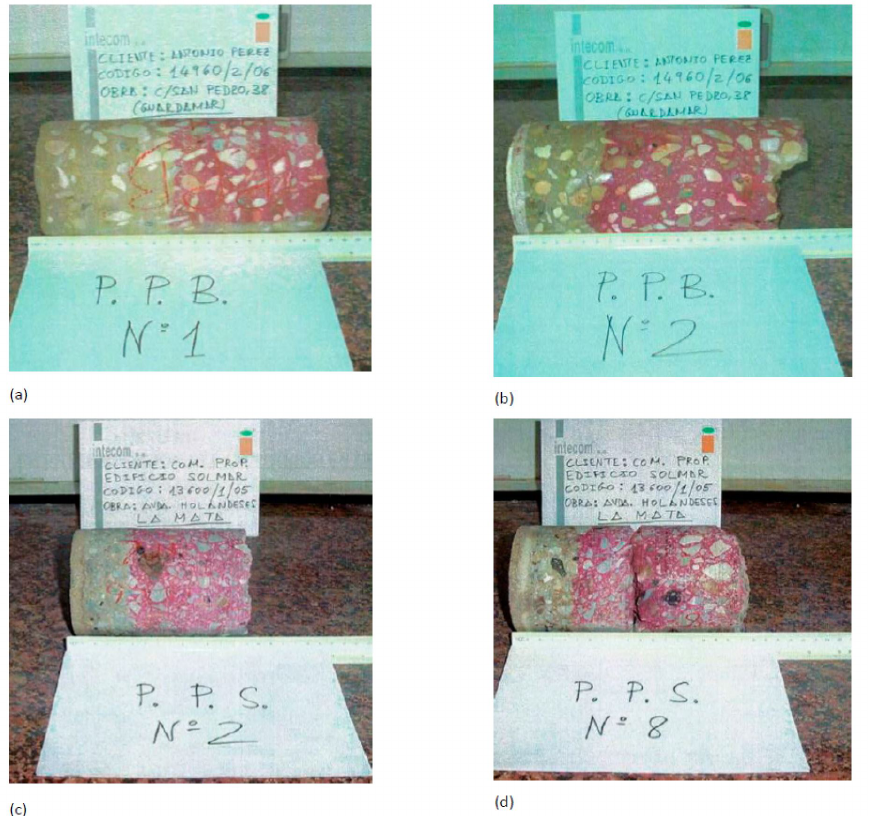
Figure 3. Depth of carbonation. ( a ) Building 2 Pillar 1. ( b ) Building 2 Pillar 2 ( c ) Building 4 Pillar 2. ( d ) Building 4 Pillar